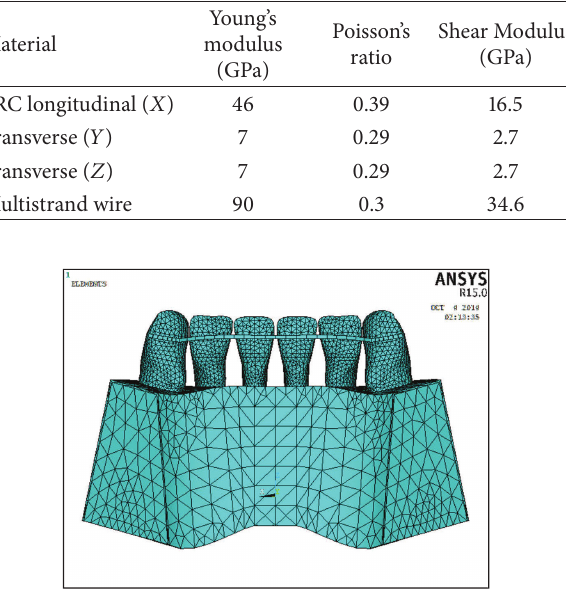
Table 1: Material properties used in this study.